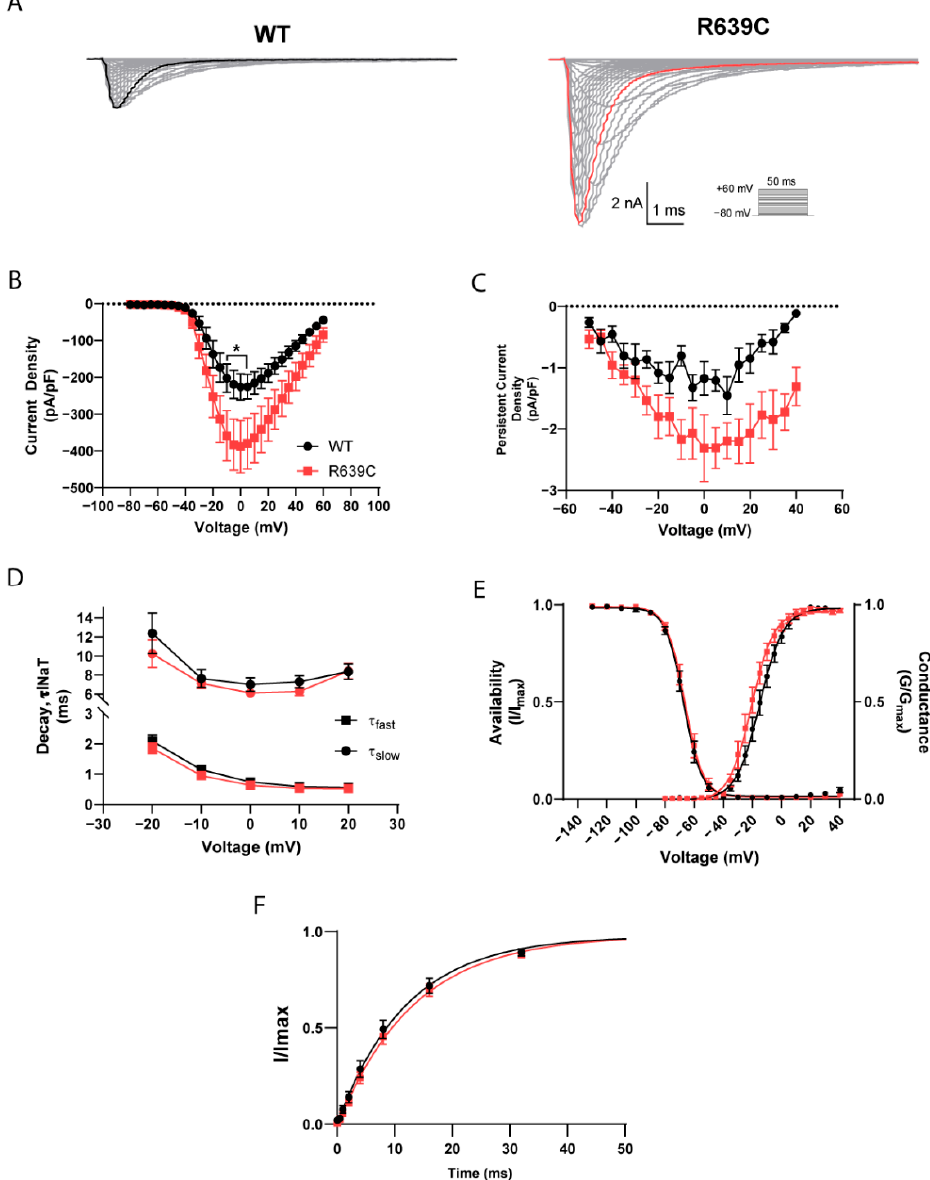
Figure 6. R639C displays substantially increased current density. ( A ) Representative current trace families from WT Nav1.6 (left) and R639C (right) channels elicited by a voltage-step protocol (inset). Boldface traces represent peak current density. ( B ) Transient and ( C ) persistent current density– voltage curves for WT Nav1.6 and R639C. ( D ) Rate of decay for transient sodium current (squares, fast τ NaT; circles, slow τ NaT) across a range of depolarization voltages. ( E ) Voltage dependence of activation and availability curves, each fitted with a Boltzmann function. ( F ) Rate of recovery from fast inactivation. R639C displays increased transient and persistent current densities compared to WT Nav1.6 in addition to a 5.08 mV left shift in the activation midpoint. * p < 0.05; n = 6–10 per group; two-way ANOVA ± SEM (error bars), Sidak’s post hoc test; Student’s t -test was performed on parameters extrapolated from curve fitting.